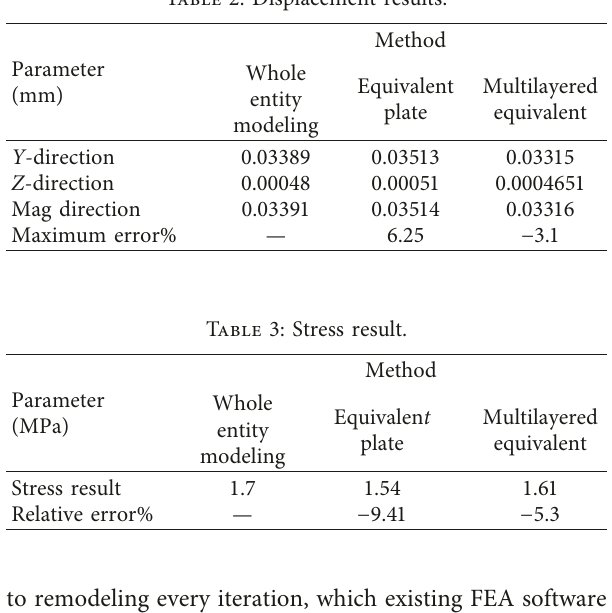
Table 2: Displacement results.